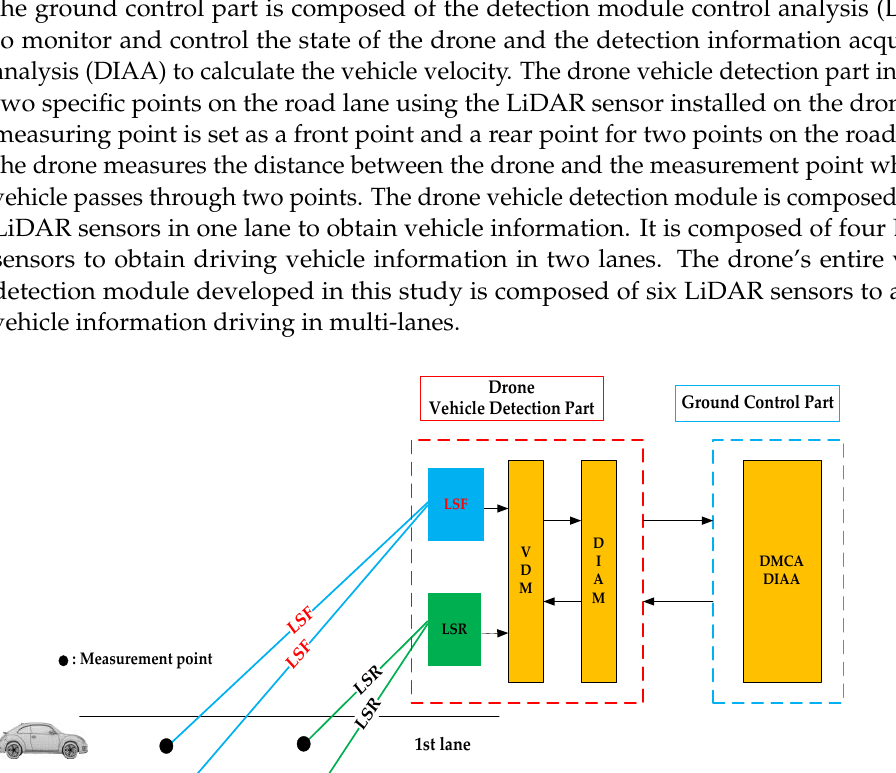
detection of the driving vehicle distance between two measuring points; 